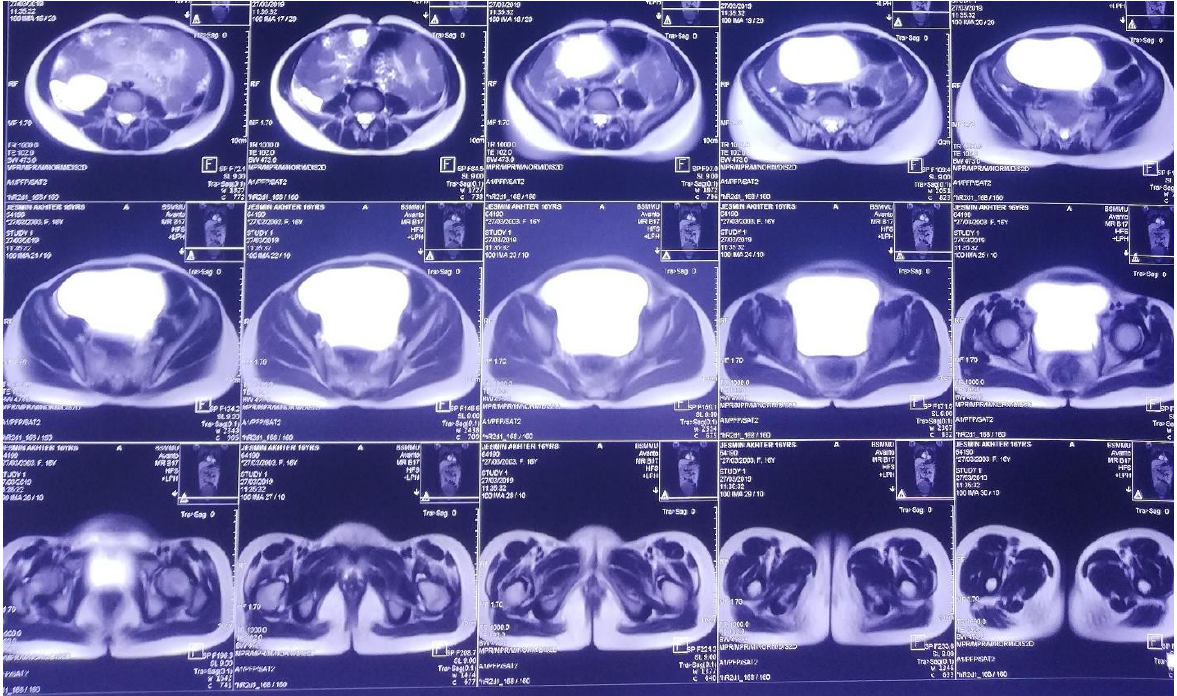
Figure – 3 , ultra sonogram of abdomen is showing dilated right kidney as well as absent uterus and adnexa.